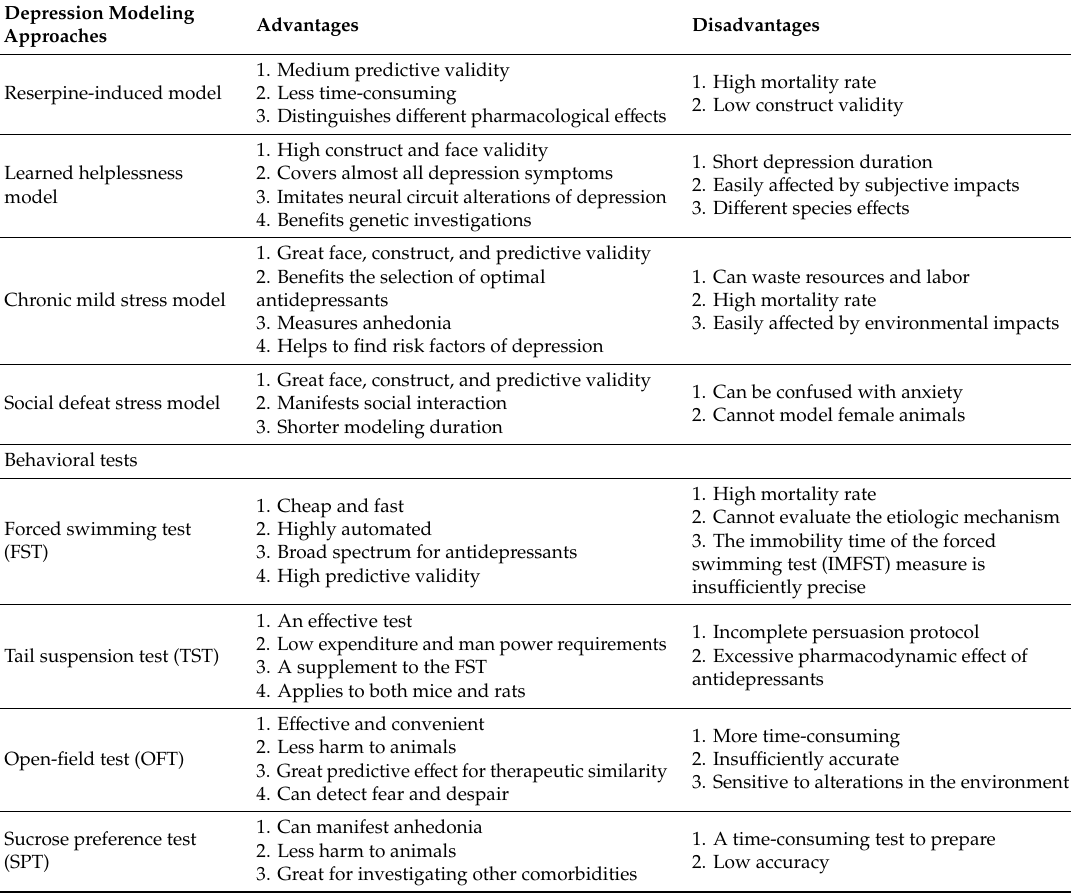
Table 1. Advantages and disadvantages of animal models of